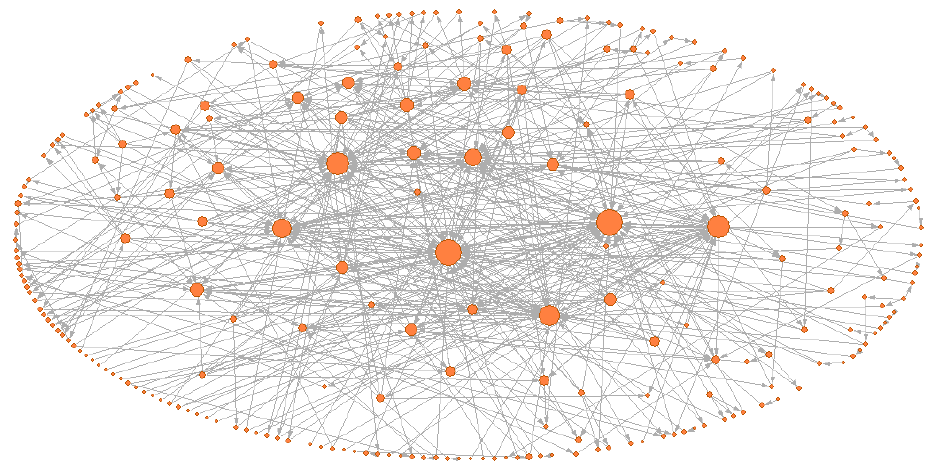
Figure 7. Betweenness centrality of